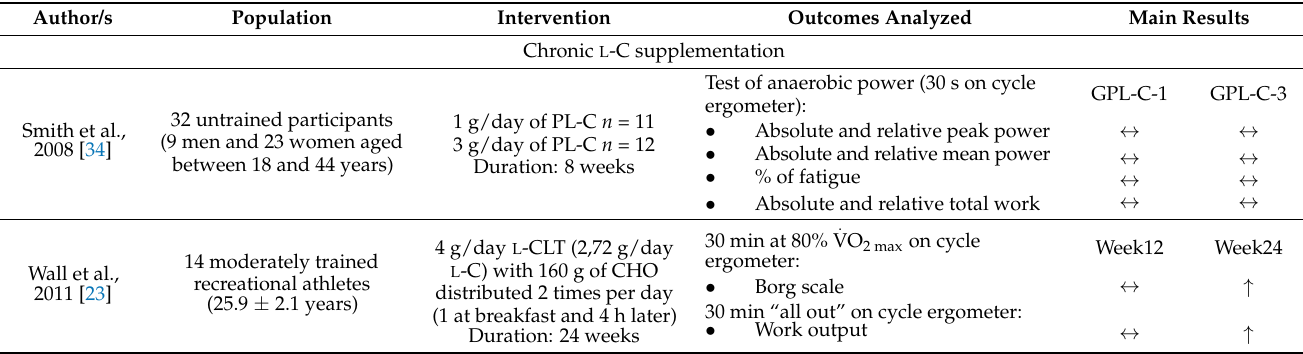
Table 3. Articles included in the systematic review that investigated the effect of L -C on high-intensity ( ≥ 80% exercise performance